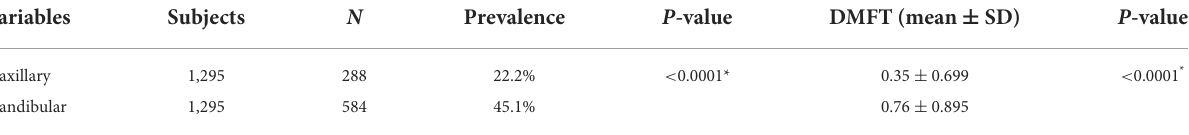
TABLE 2 Prevalence of caries, DMFT of first permanent molar in different locations ( N = 1,295).